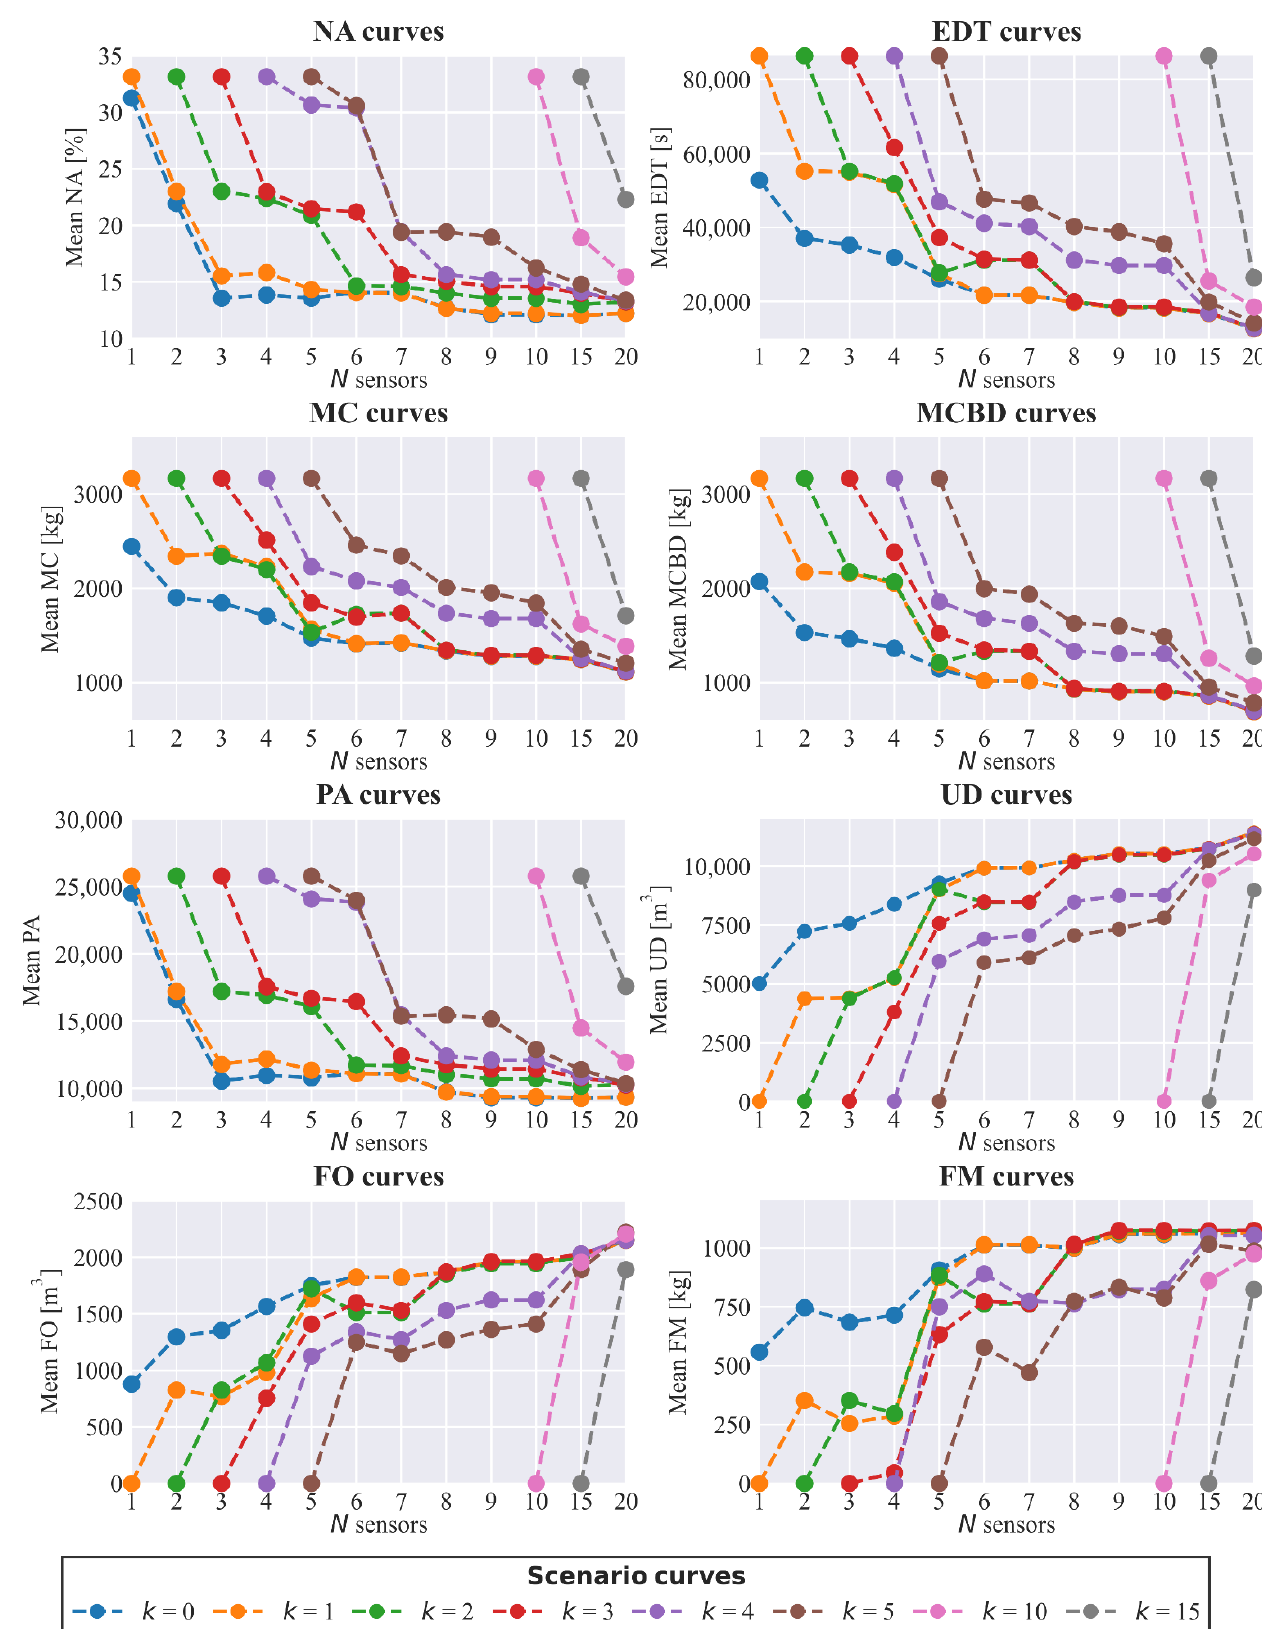
Figure 5. Metric curves from the results of the simulations.